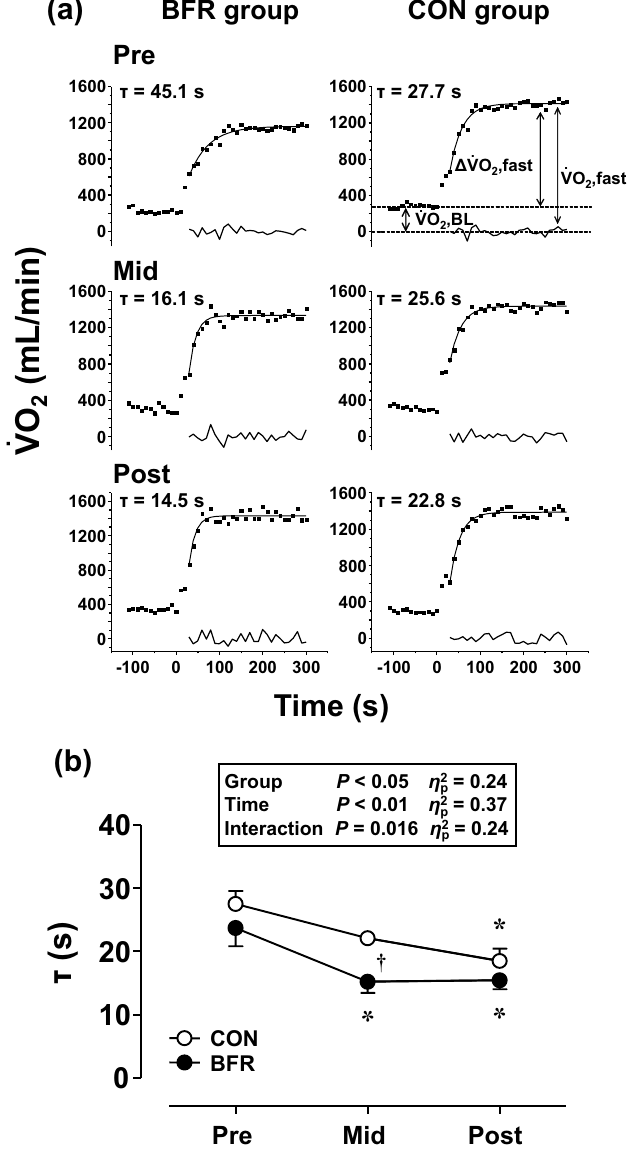
˙ VO Figure 2. Representative oxygen uptake ( 2 ) response to moderate-intensity constant-load exercise ( a ) and group means of time constant (τ) of the fast component during moderate-intensity constant-load exercise ( b ) before (Pre), 4 weeks after (Mid), and 8 weeks after (Post) cycle training with (BFR group) or without (CON ˙ VO ˙ VO (cid:31) ˙ VO2 , fast, the asymptotic amplitude group) blood flow restriction (BFR) ( a ): 2 , BL, the baseline of 2 ; ˙ VO ˙ VO of the fast component (the increase in 2 from the baseline to the asymptote of the fast component); 2 , fast, the absolute asymptotic amplitude of the fast component (the sum of the baseline and the asymptotic amplitude). ( b ): Values are expressed as means ± SE. Statistical analysis was performed using a repeated- measures two-way analysis of covariance, followed by Bonferroni’s multiple comparisons test. Partial eta squared (η p2 ) is the effect size of the interaction and main effects of group and time. *Significant difference from Pre ( P < 0.01). †Significant difference between BFR and CON groups at that time point ( P <